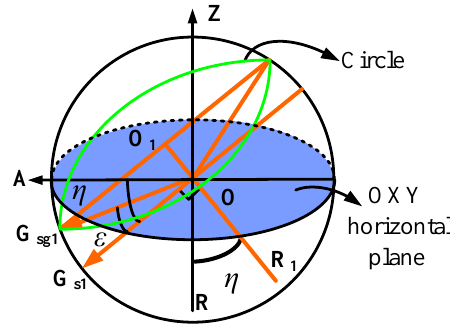
Figure 5. The gyro axis’s trajectory with the shaft misalignment and the gyro misalignment when the shaft is rotated counterclockwise around the shaft for 360 ◦ (the sphere is not the earth, but used to facilitate understanding of the